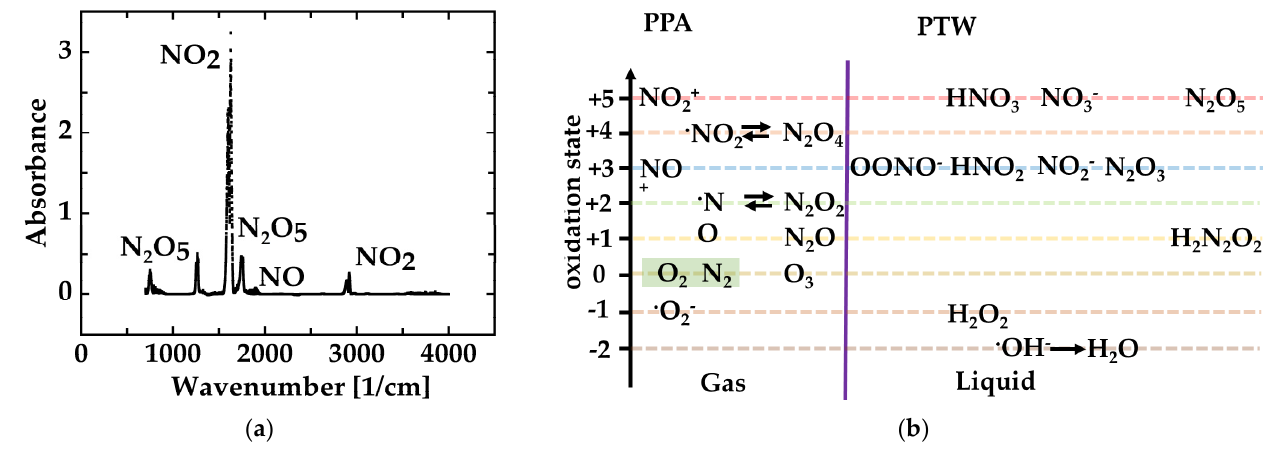
Figure 2. The figure summarizes the theoretical background, which delivers the assumptions made for the interpretation of the PTW mechanisms of actions: ( a ) Interpretation scheme for combined testing of what is contained in the first panel; ( b ) Overview of compounds and their oxidation steps found in PPA in FTIR measurements and in analytics of PTW. Table 1. Summary of traceable compounds found (via IC and potentiometric measurements) in freshly generated PTW. For an accurate determination of the NO 2 -concentration, possible chemical reactions such as oxygenation of NO 2 to NO 3 were impeded by the addition of